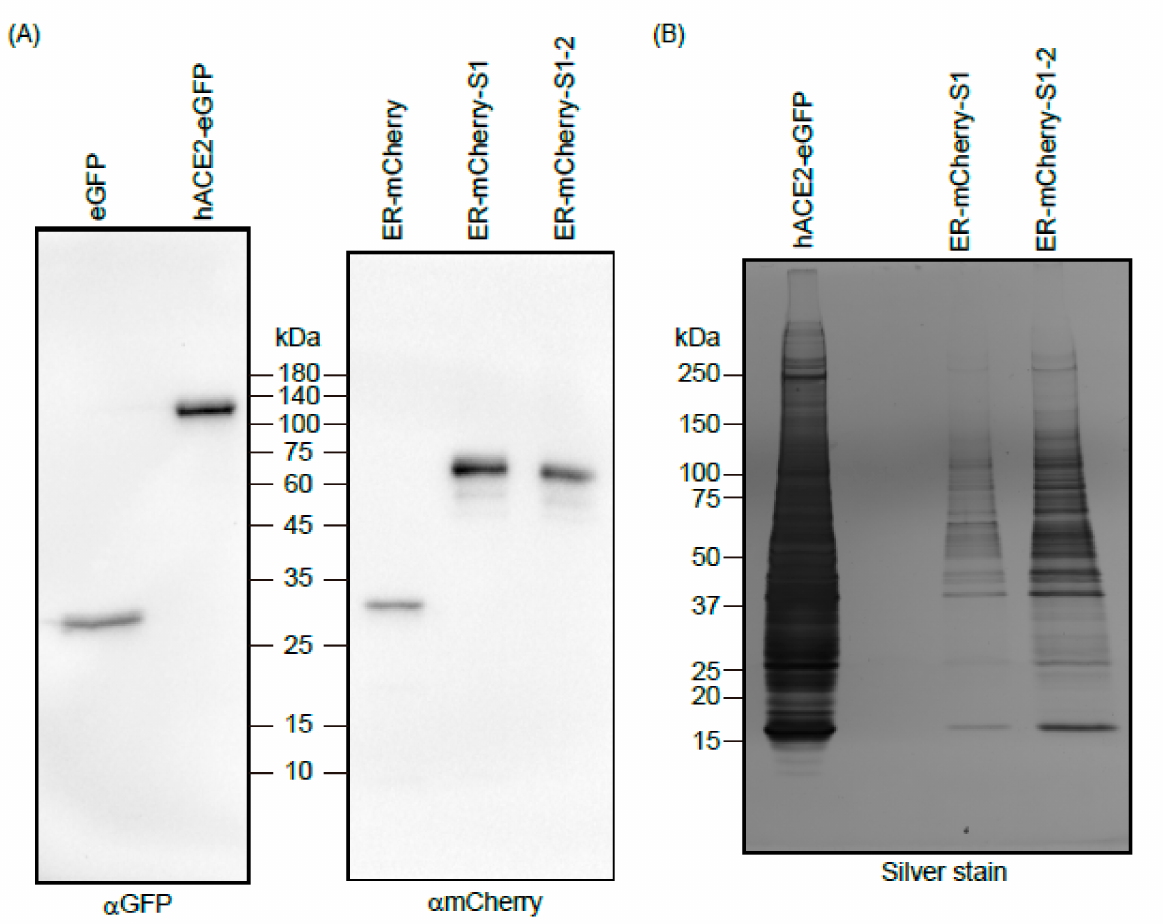
Figure 2. Confirmation of purified recombinant hACE2-eGFP, ER-mCherry-S1, and ER-mCherry-S1-2. ( A ) Western blot of purified recombinant eGFP, hACE2-eGFP, ER-mCherry, ER-mCherry-S1, and ER-mCherry-S1-2 using anti-GFP and anti-mCherry antibodies (left and right, respectively). ( B ) SDS-PAGE gel followed by silver staining of purified hACE2-eGFP, ER-mCherry-S1, and